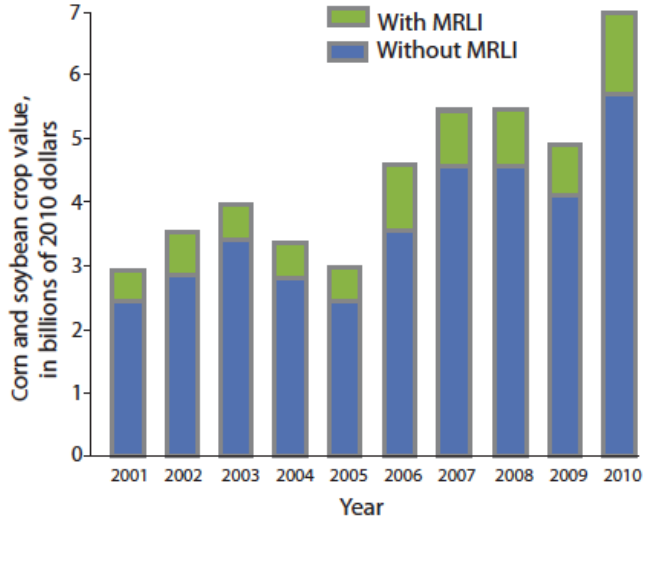
Figure 5. Bar graph showing the annual flow of economic benefits (2001–2010) with and without the availability of MRLI for the 35-county northeastern Iowa region (source: